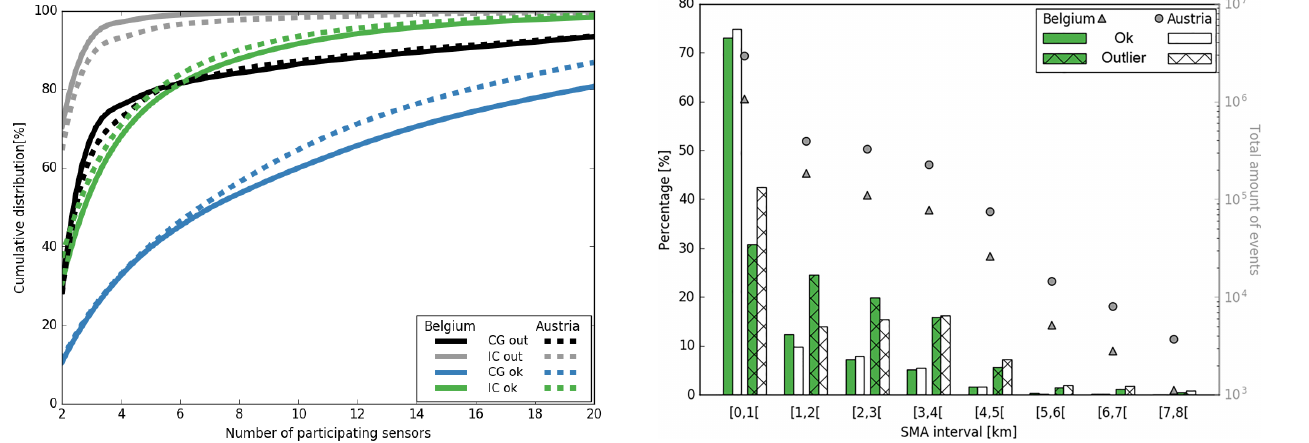
Figure 10. Distribution of the semi-major axis (SMA) of the out- liers and “ok” events in Belgium and Austria for a search radius of 2km. In addition, the total amount of events per SMA interval is indicated as grey triangles (Belgium) and circles